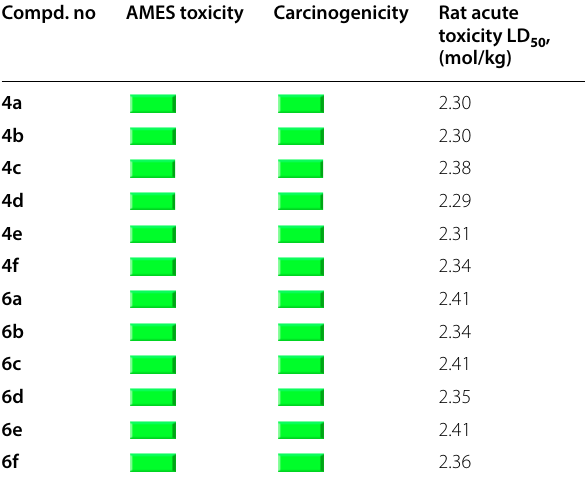
Table 6 In silico predicted LD of the synthesized sulfonamides 4a–f and 6a–f [70] Compd. no AMES